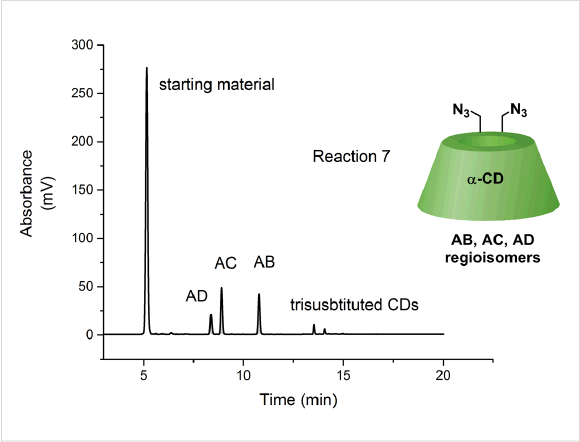
Figure 3: HPLC chromatograms of reaction 7 with separated 6 A -azido- α -CD 7 as starting material and regioisomers of 6 A ,6 X -diazido- α -CD 4 .